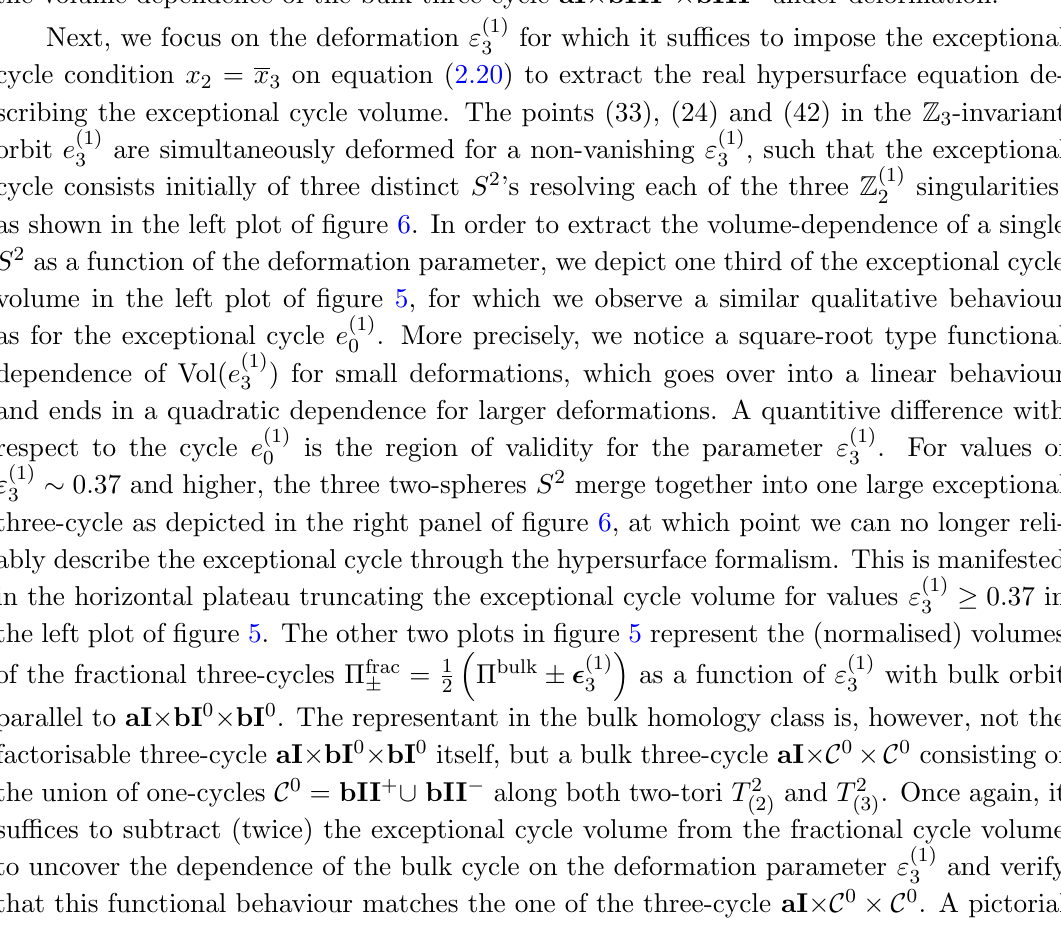
Figure 4 . Normalised volume of the exceptional cycle e (1) (cid:5) frac